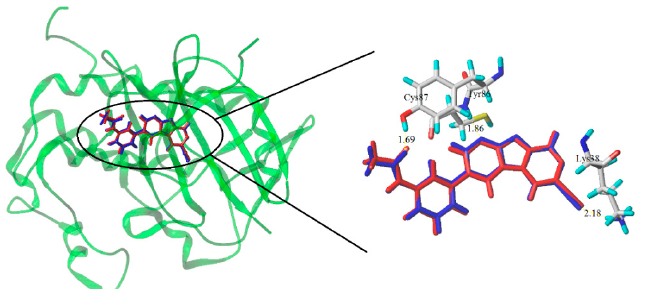
Figure 8. Re-docking results of the compound into the binding site of Chk1 protein and the crystal structure ( blue ribbon ) for the compound complex. The re-docked ligand ( blue ) and the original ligand ( red ) shown as a stick model. The hydrogen-bonds are shown as yellow lines, with distance unit of Å.